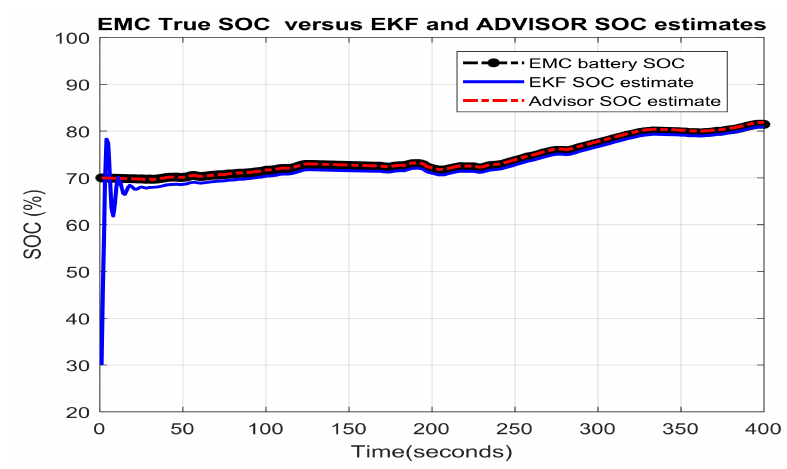
Figure 23. The 3RC EMC SOC model versus EKF SOC and ADVISOR SOC estimates for T = 5 ◦ C.